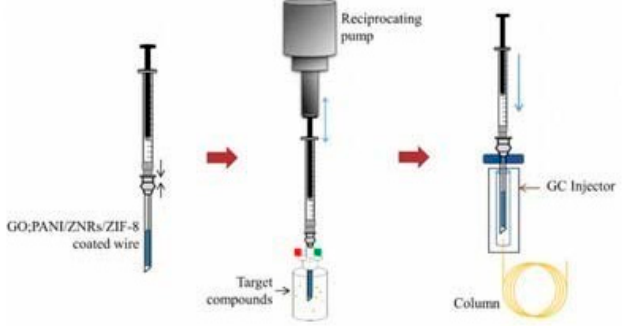
Figure 1. A scheme of INME process [1]. Reprinted from Molecules 2022, 27 (15),